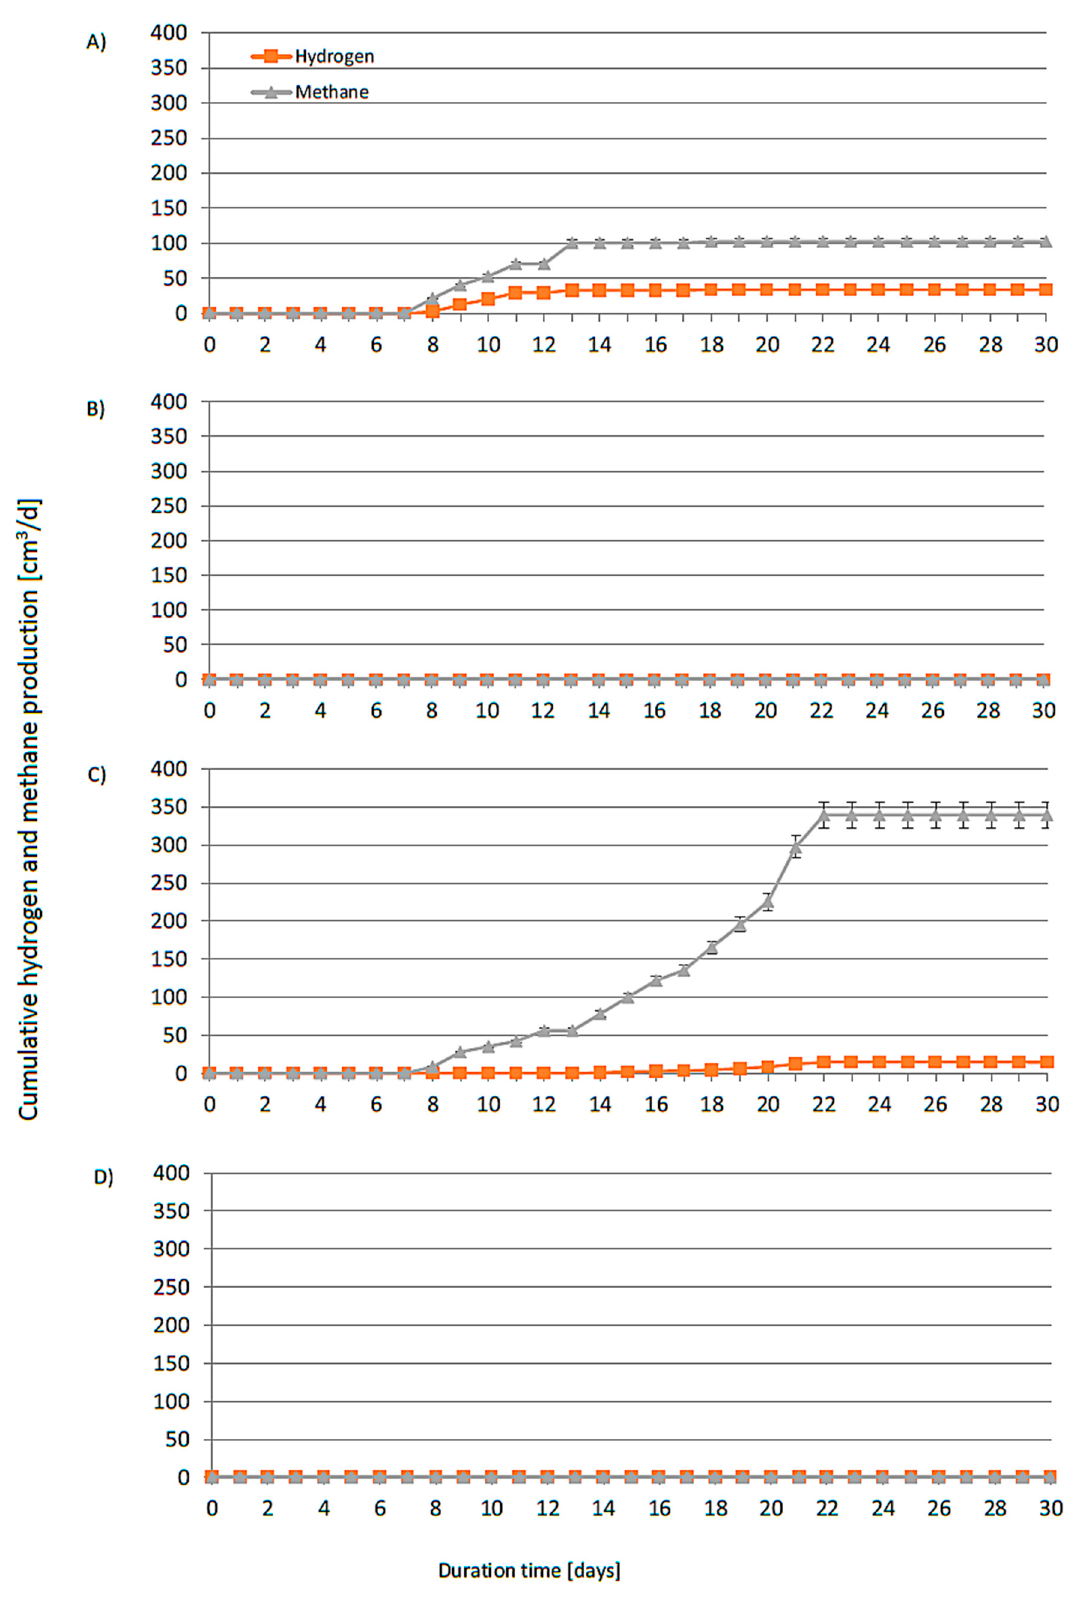
Figure 19. Daily average specific hydrogen and methane production from cotton hydrolyzed in DF systems (mesophilic conditions) with ( A ) H 2 SO 4 neutralized with NaOH, ( B ) H 2 SO 4 neutralized with KOH, ( C ) H 3 PO 4 neutralized with NaOH, and ( D ) H 3 PO 4 neutralized with KOH.